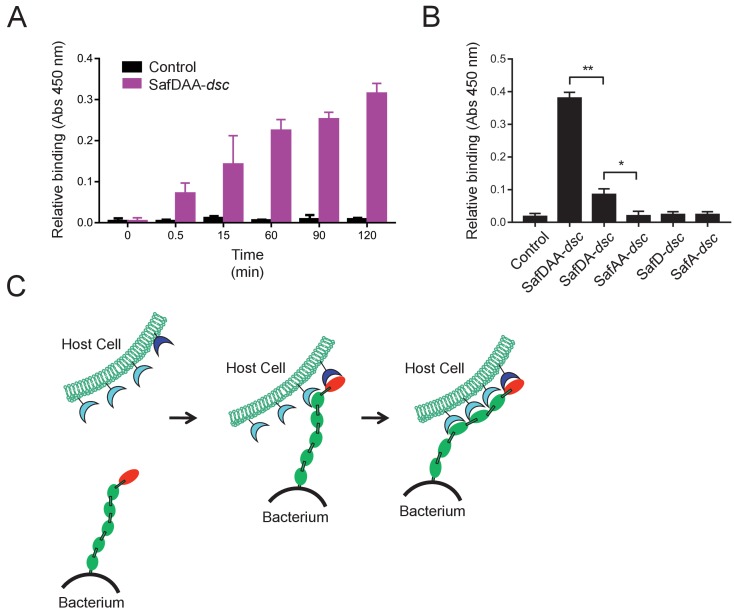
Host recognition by Salmonella Saf pili.(A) Cell adherence assay. 3 μM SafDAA-dsc was incubated with IPEC-J2 cells and the relative biniding of SafDAA-dsc was monitored at different time points up to 2 hr. 3 μM recombinant protein His-SH3 was used as control. (B) The binding activities of SafDAA-dsc, SafDA-dsc, SafAA-dsc, SafD-dsc and SafA-dsc. 10 μM recombinant Saf proteins were incubated with IPEC-J2 cells for 1 hr prior to ELISA analysis. All experiments have been done at least with three independent replicates. Values are means ±S.E. *p<0.05 and **p<0.01 (derived from student t test) are used to show statistically significant between recombinant derivatives. (C) The poly-adhesive host recognition mechanism by Saf pili. In the first step, the SafD (red) located in the distal tip of the pilus can mediate the initial host recognition. The unkonwn host receptor is colored in blue. In the second step, an intimate host:bacerium association leading to bacterial colonization and diseases can be formed by the sequential binding of SafA subunits (green) with a separate set of host receptors (cyan).10.7554/eLife.28619.010Figure 4—source data 1.Source data for Figure 4A.Cell adherence measured by OD450 absorance values (three replicates).10.7554/eLife.28619.011Figure 4—source data 2.Source data for Figure 4B.Cell adherence for SafDAA-dsc and mutants measured by OD450 absorance values (three replicates).